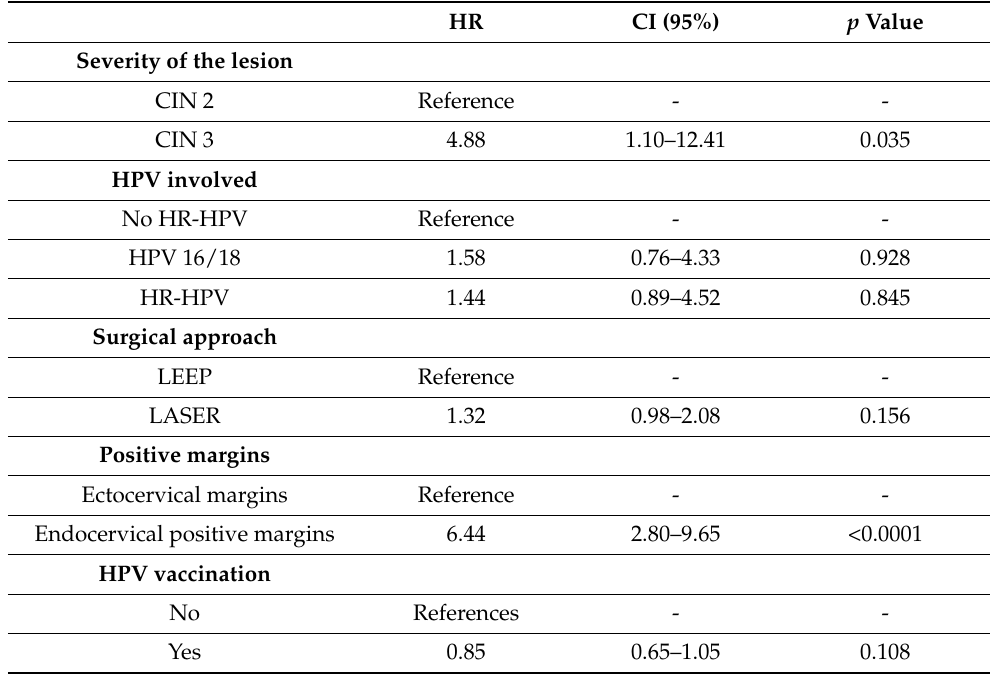
Table 2. Univariate recurrence of cervical dysplasia